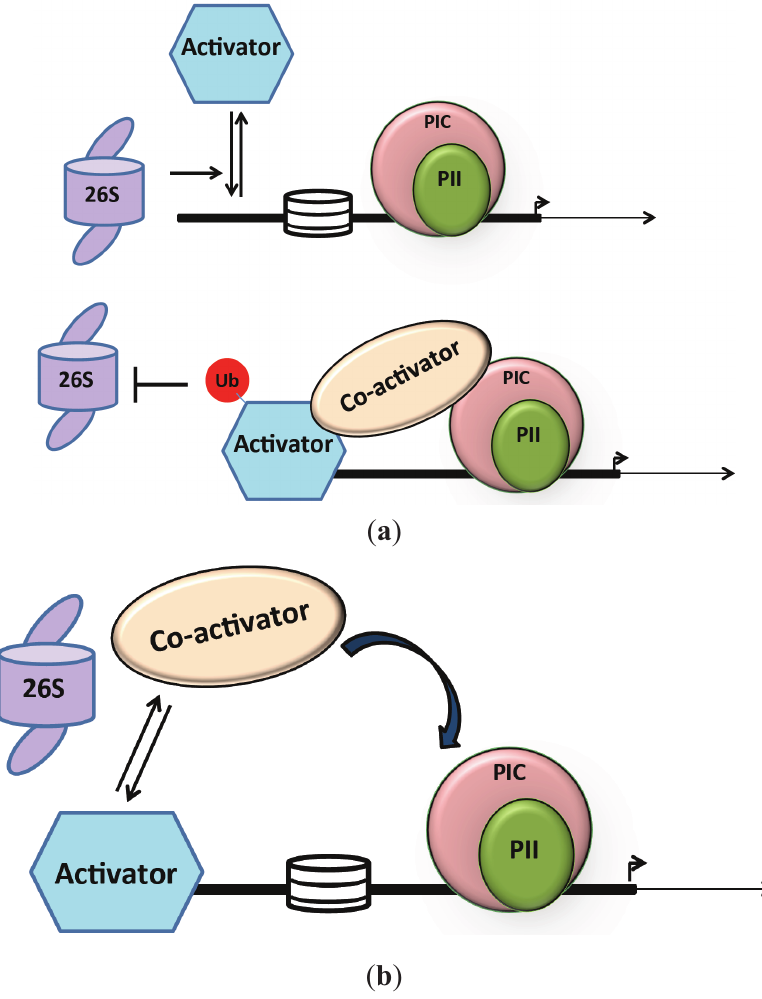
Figure 3 . Proteolysis independent roles of the 26S proteasome in activation of transcription. ( a ) 19S components of the 26S proteasome are involved in “stripping” of activators from promoters. Mono-ubiquitylation of the activator renders it resistant to the “stripping activity”; ( b ) 19S subunit of the 26S proteasome stimulates the interaction between activator-coactivator complexes leading to an enhanced association of PIC on the